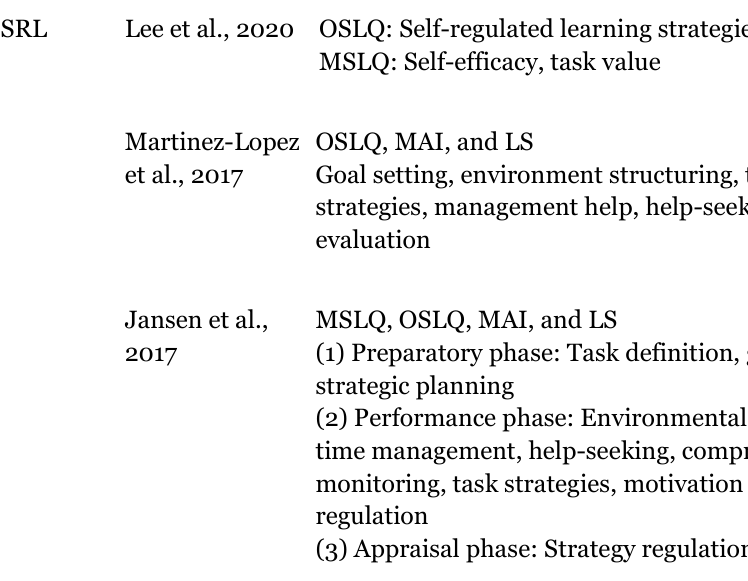
10 Typical Articles About Learners’ Performance in MOOCs